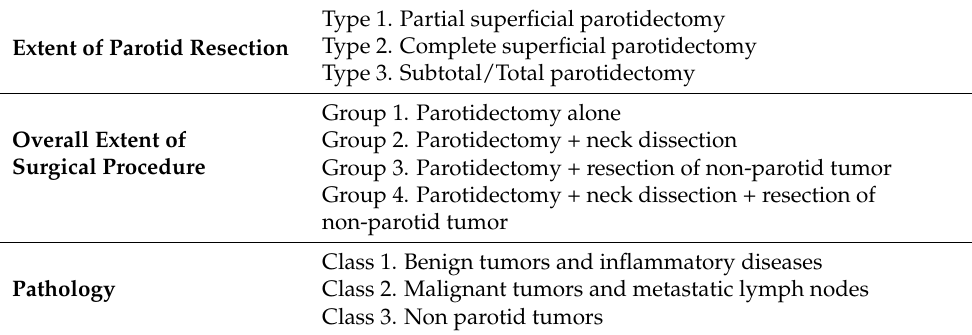
Table 1. Classification of surgical procedures according to extent of parotidectomy, extent of overall surgical procedure, and pathology.